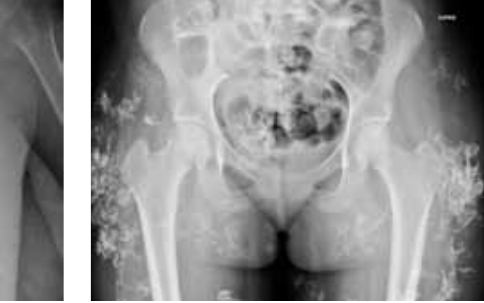
Fig. 2a. Frontal radiograph of the pelvis demonstrating extensive soft-tissue calcification.